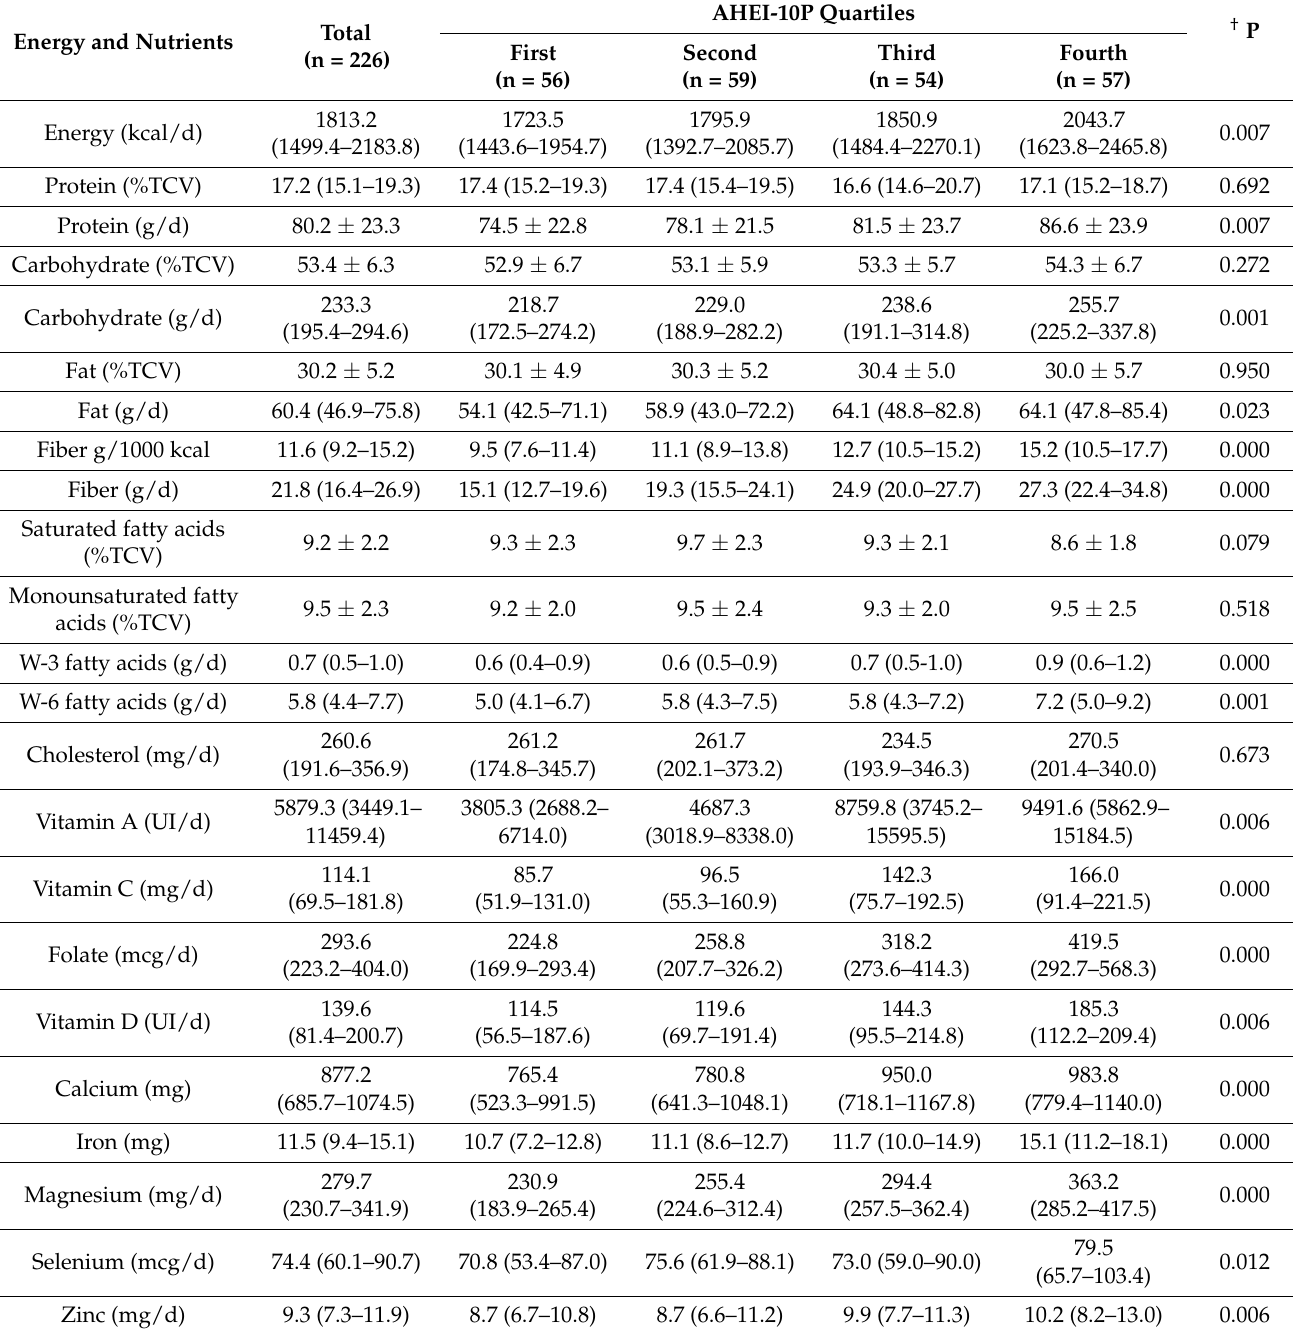
Table 3. Total energy and nutrient intake during the 2nd half of pregnancy according to the AHEI-10P